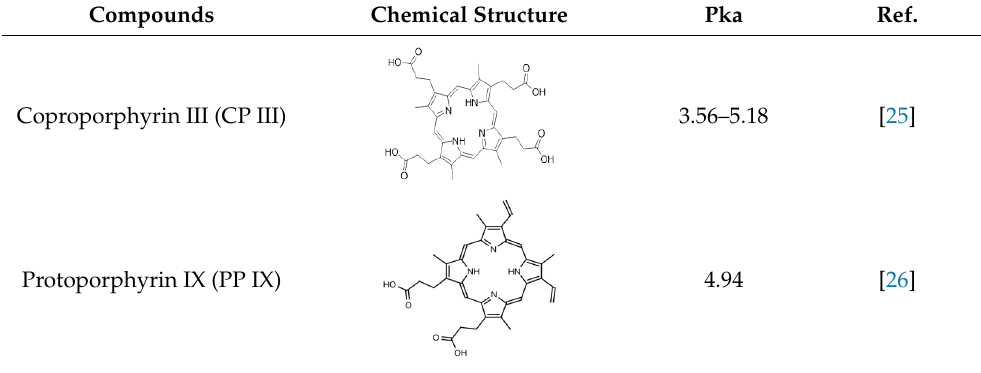
Table 1. Cont. Compounds Chemical Structure